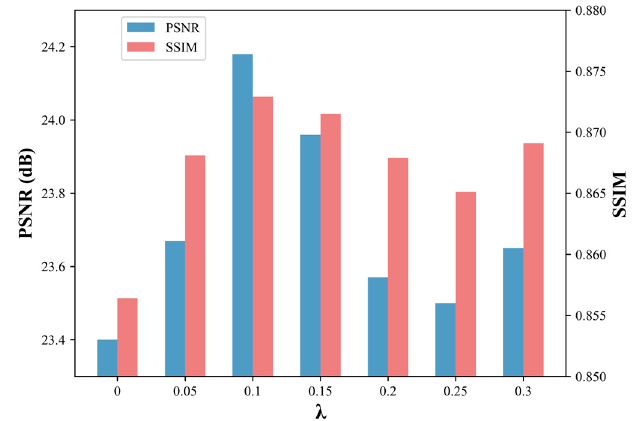
Figure 13. The ablation study for parameter λ of the loss function.